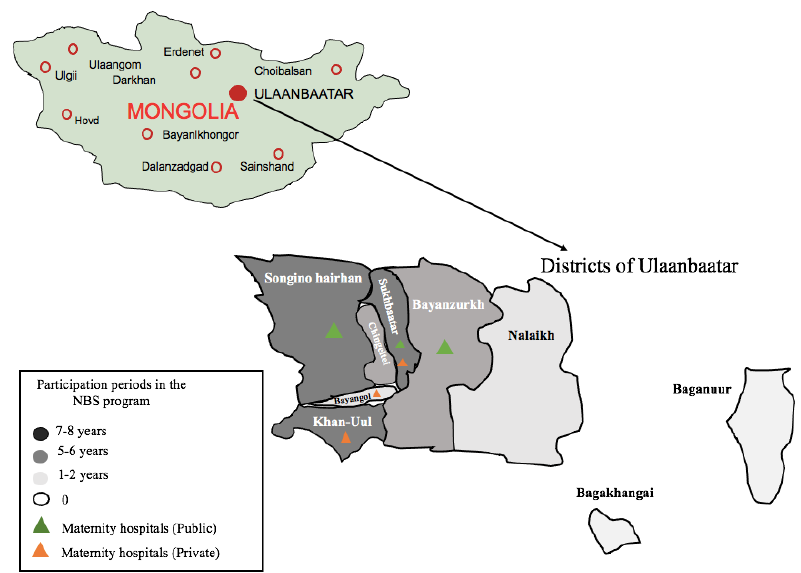
Figure 1. Participation periods (years) for the nine districts of Ulaanbaatar; six maternity hospitals are involved in the NBS program for CH. The map shows, in shades of light grey, dark grey, and black, the nine districts (out of nine in Ulaanbaatar); colored triangles show the six maternity hospitals (out of seven in Ulaanbaatar).